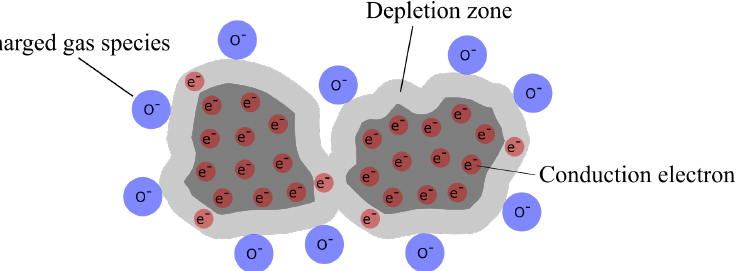
Figure 1. Semiconducting metal oxide particles with charged adsorbates, creating a zone of charge carrier